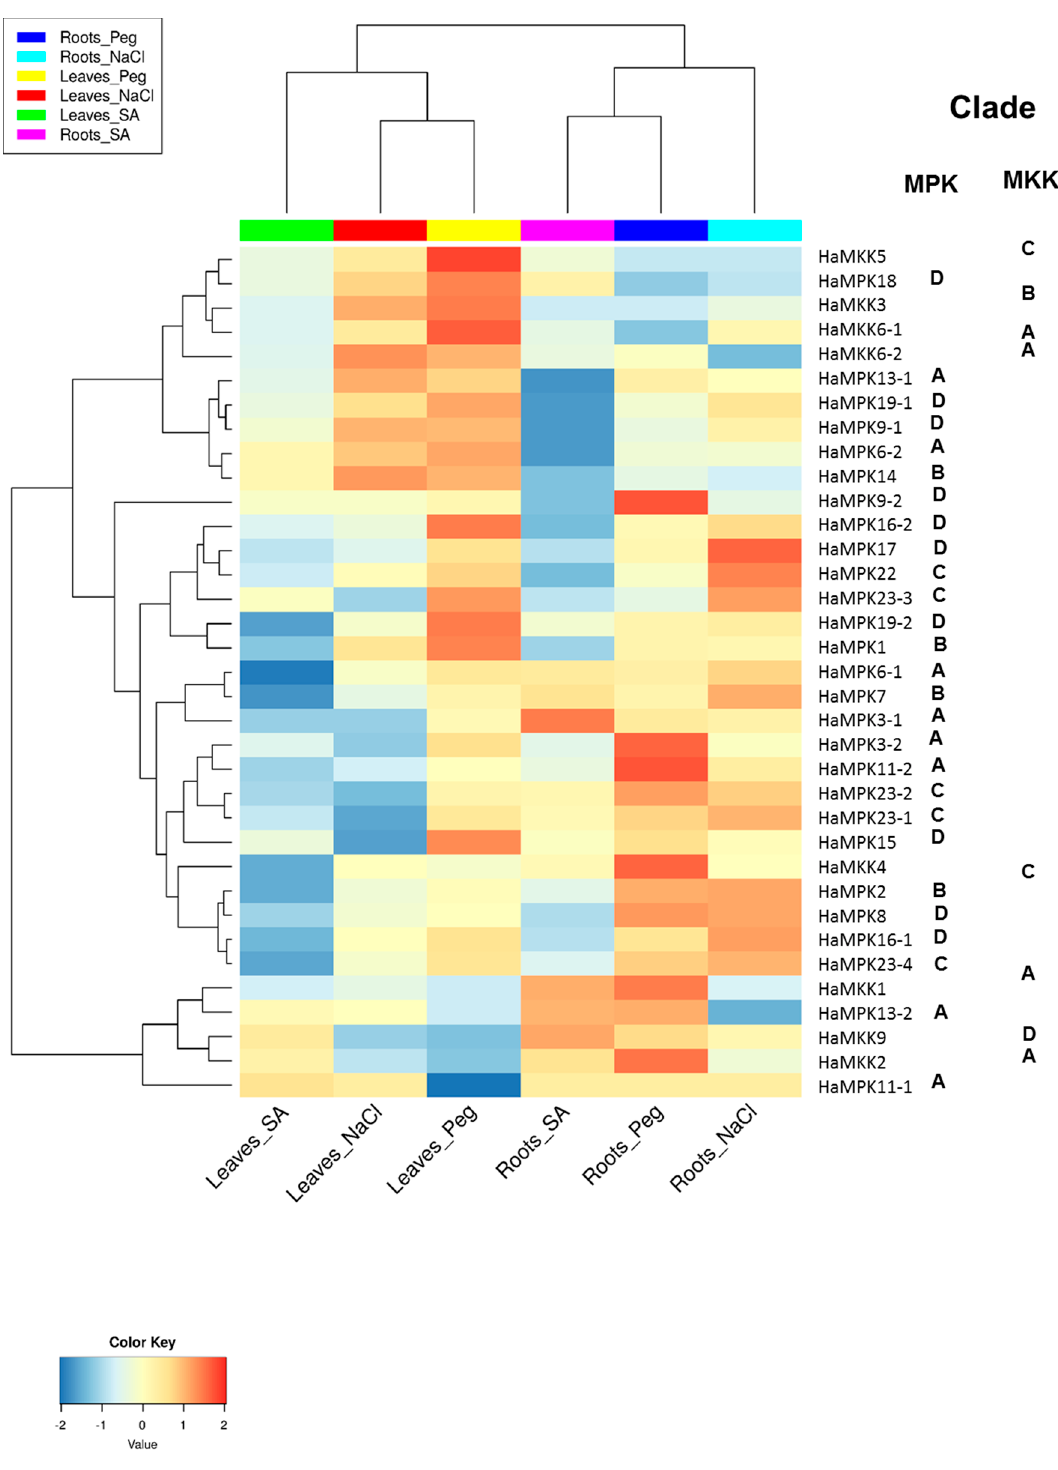
Figure 6. Expression profile of sunflower MPK and MKK genes visualized as a heatmap, with clade information. The heatmap was generated using log 2 FC values. The expression pattern is in response to salicylic acid (SA), salt (NaCl) and polyethylene glycol (Peg) in leaves and roots. The RNA-seq data was accessed from NCBI SRA SRP092742 [SRR4996815 (Roots Peg), SRR4996819 (Roots_NaCl), SRR4996823 (Leaves_Peg), SRR4996828 (Roots_Control), SRR4996834 (Leaves_NaCl), SRR4996836 (Leaves_Contol), SRR4996839 (Leaves_SA), and SRR4996847 (Roots_SA)].